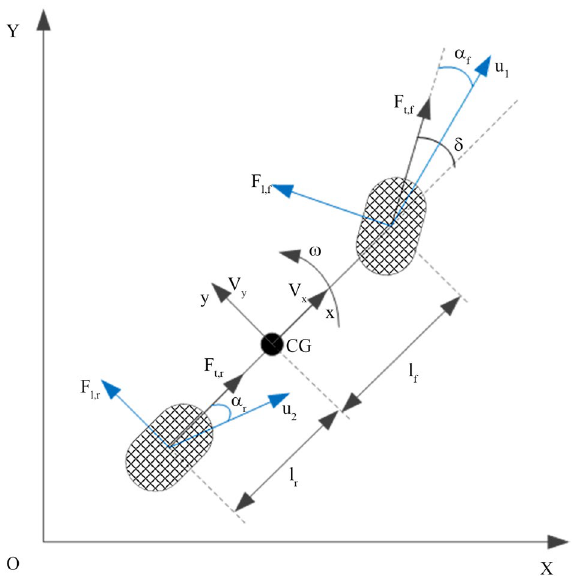
Figure 3. Tractor yaw dynamics